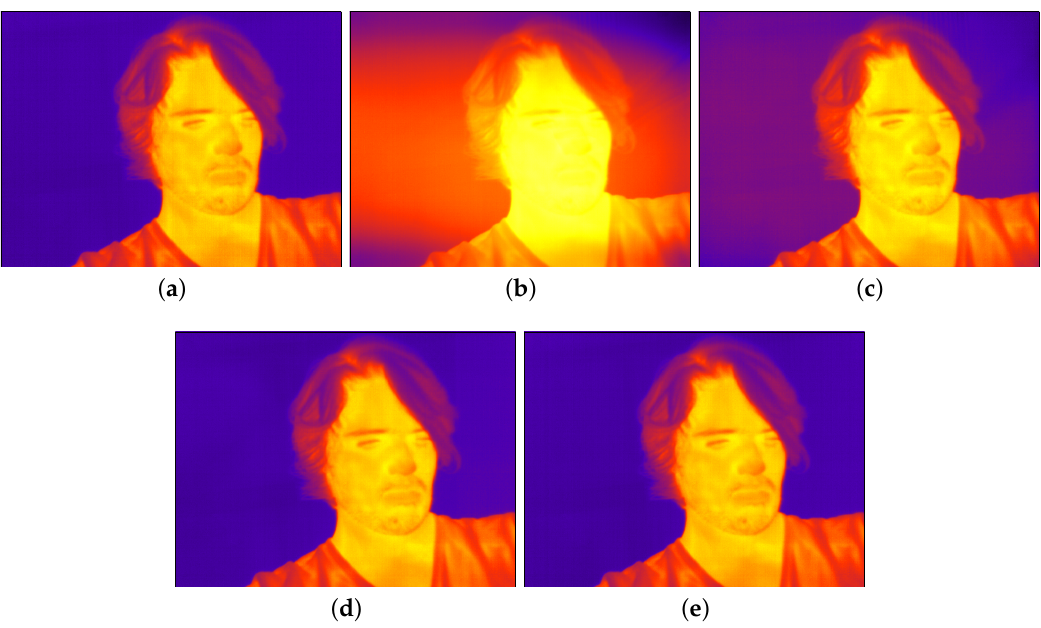
Figure 8. ( a ) Sample raw frame taken from a sequence of IR data. NU compensated versions of the raw frame obtained using: ( b ) Scribner’s retina-like method; ( c ) Enhanced Constant Range method; ( d ) Kalman filter NUC method; and ( e ) Proposed method.